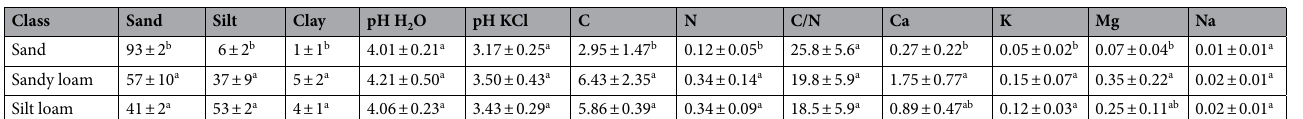
Table 1. Basic properties of analysed soils. Mean ± standard deviation; sand, silt and clay content (%); carbon and nitrogen content (%); Ca, K, Mg and Na content (cmol(+)/kg). Small letters in the upper index of the mean values mean significant differences between texture